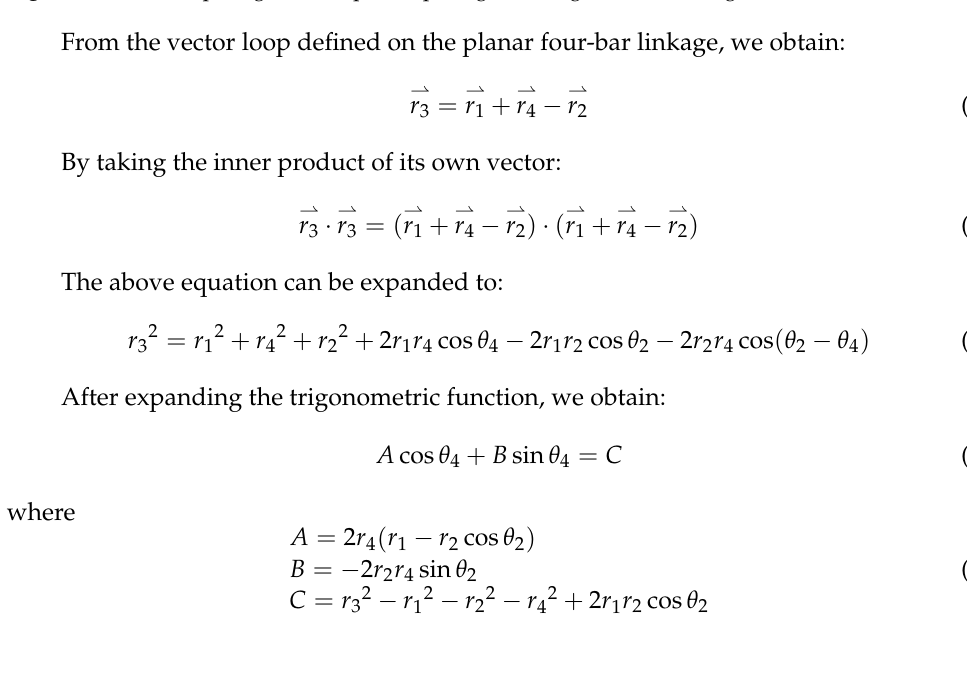
Figure 1. Vector loop diagram of a planar path-generating four-bar linkage.